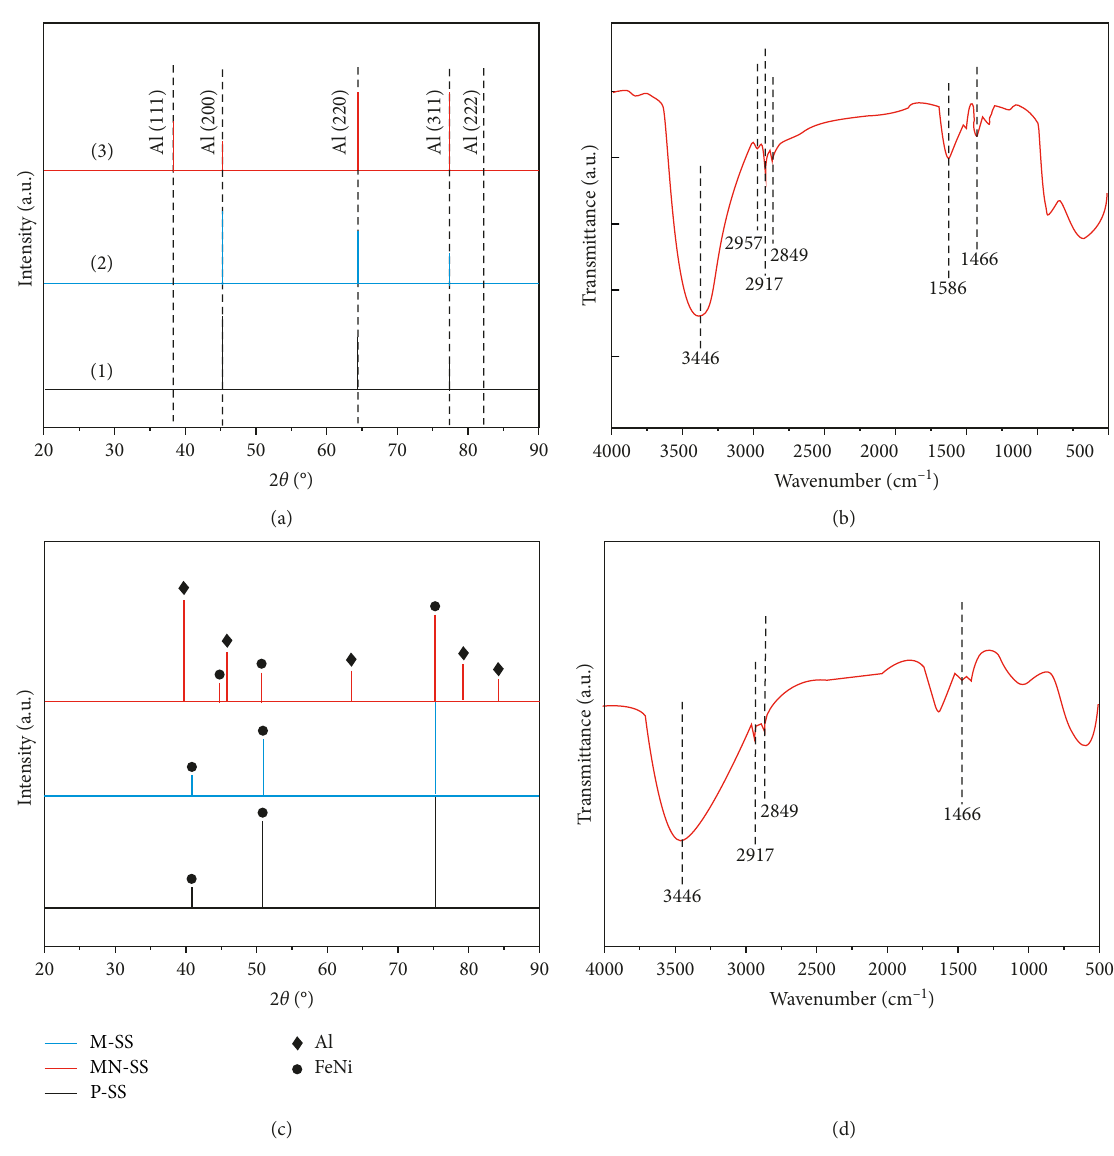
Figure 3: (a) The powder X-ray diffraction patterns of (1) P-Al, (2) M-Al, (3) MN-Al surface and (c) P-SS, M-SS, MN-SS surface, FTIR spectra of the (b) MN-Al and (d) MN-SS surface after STA